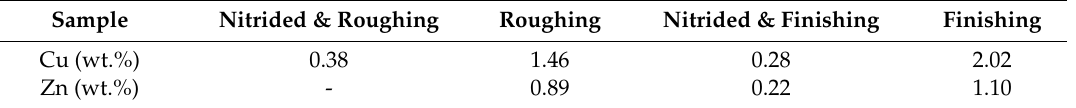
Table 4. EDS values of Cu and Zn on the surface of the wore discs for the four type of surface conditions and brass pins. Sample Nitrided & Roughing Roughing Nitrided & Finishing